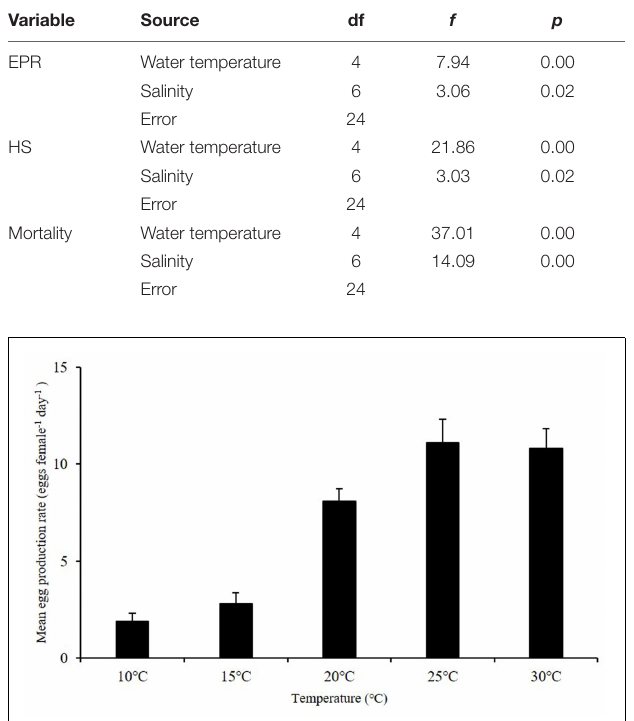
FIGURE 1 | Egg production rate (EPR) of adult female Acartia ohtsukai at each temperature. For each treatment, the mean 24-h EPR at seven salinities (10, 15, 20, 25, 27, 30, and 33 psu) is shown. Data are presented as mean ± standard error (SE). Different letters above the bars indicate significant differences ( p <